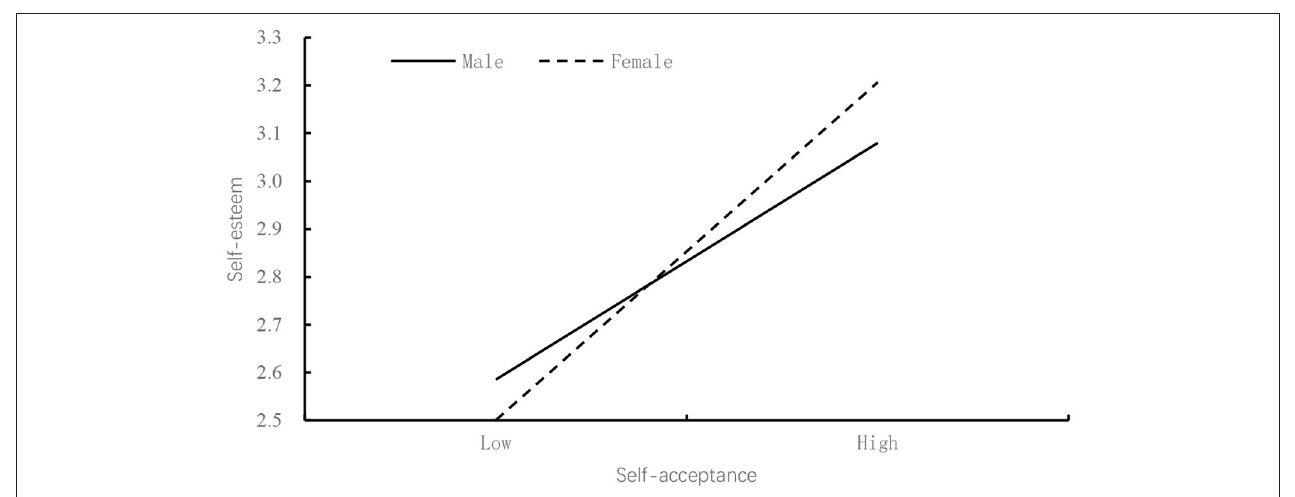
FIGURE 2 | Gender moderates the relation between Self-esteem and